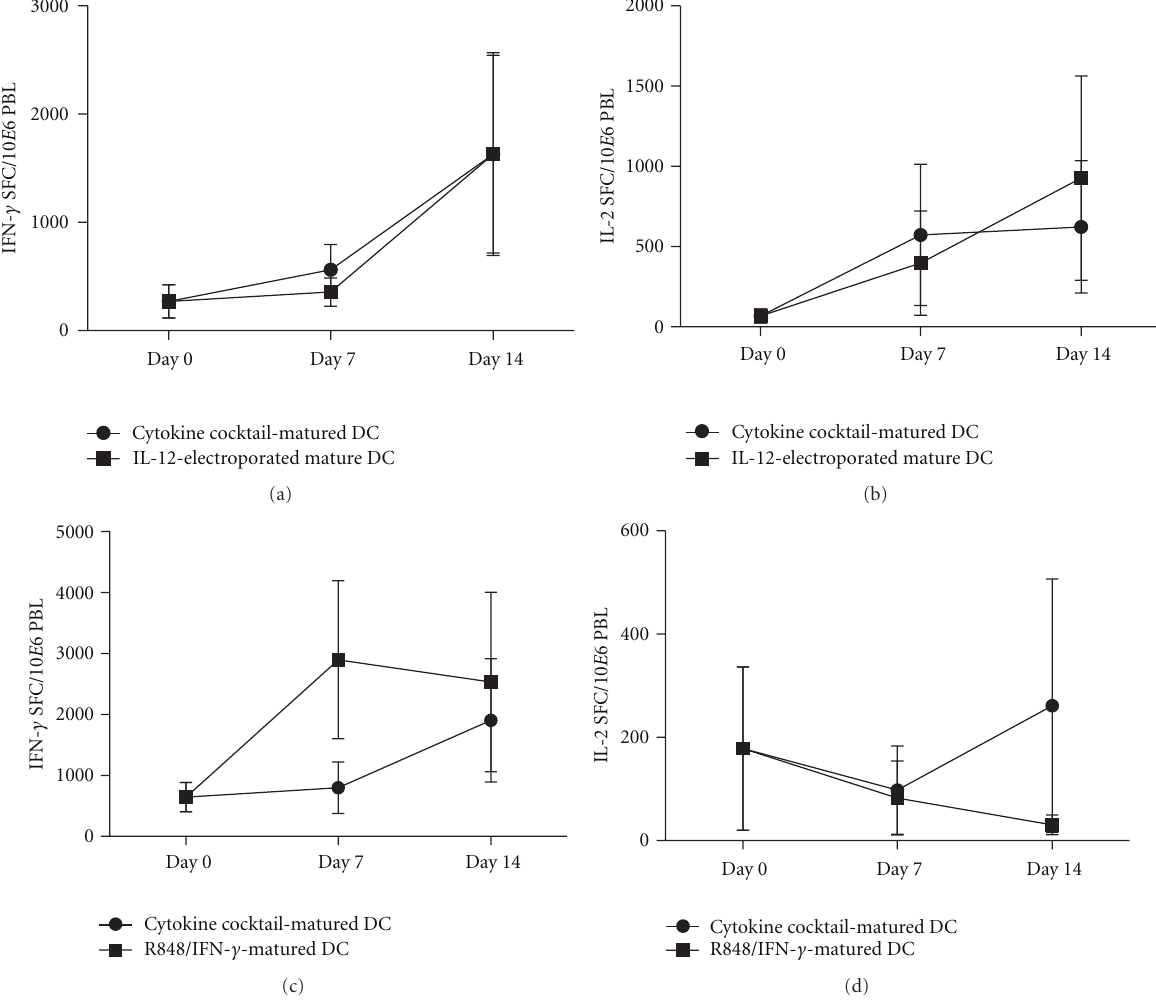
Figure 4: Stimulatory capacity of DCs from HIV-seropositive individuals after a second stimulation round. Freshly thawed PBLs were directly incubated in ELISpot with gag -derived peptides (Day 0), or PBLs were stimulated for one week with autologous gag mRNA- electroporated DCs (day 7), or PBLs were stimulated for a second week with thawed autologous electroporated DCs and reevaluated in ELISpot (day 14). For this, DCs were matured with a simplified cytokine cocktail (TNF- α and PGE 2 ) or with a simplified cytokine cocktail in combination with IL-12p70 mRNA electroporation (a) and (b), or with a simplified cytokine cocktail in combination with TLR7/8 ligand resiquimod (R848), and IFN- γ (c) and (d). Cocultured PBLs were evaluated for antigen-specific secretion of the following cytokines: IFN- γ (a) and (c) and IL-2 (b) and (d). Results are shown as mean of triplicate analyses for each donor displaying a positive response ( n = 2), as defined in the Materials and Methods